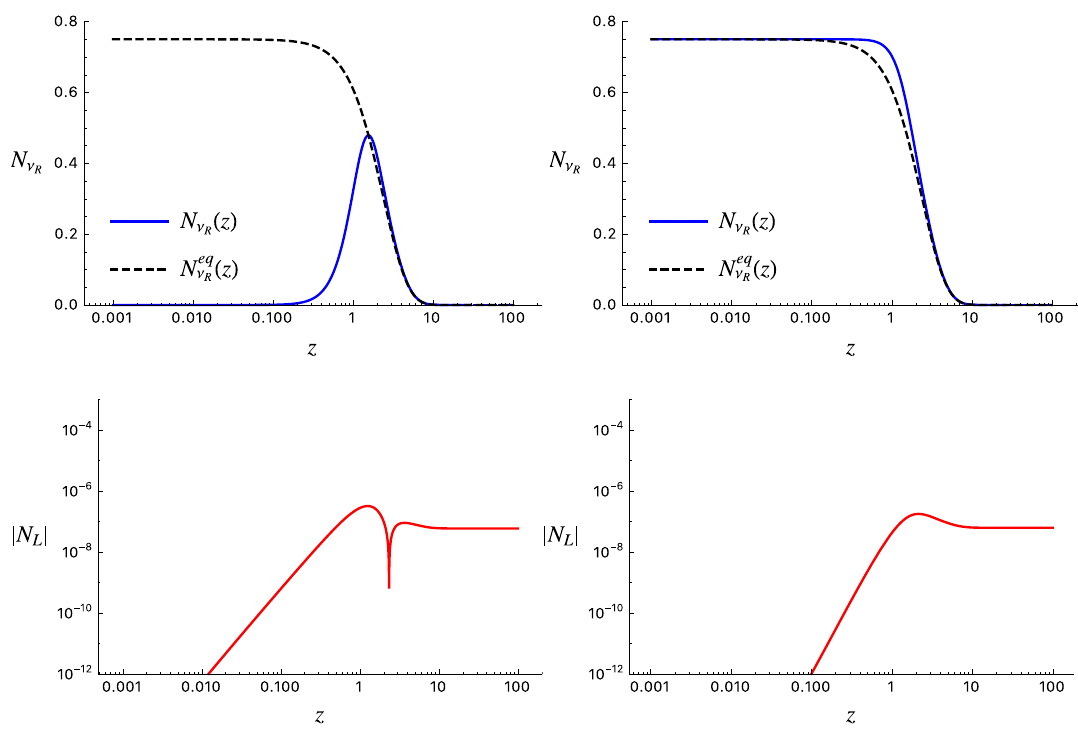
Figure 14 . The upper (cid:12)gures show the development of the sterile neutrino densities N (cid:23) left-hand diagram corresponds to an initial condition with N (cid:23) starts with N (cid:23) ( z ) already at its equilibrium value. The lower (cid:12)gures show the corresponding R absolute value of the lepton asymmetry induced by the out-of-equilibrium decays of (cid:23) 1 cusp in the left-hand plot, indicating that the asymmetry N L ( z ) changes sign as the sterile neutrino density N (cid:23) ( z ) switches from under to just over its equilibrium value. The parameters here are R M 1 = 5 (cid:2) 10 10 GeV and K = 5, with " 1 = 10 (cid:0) 6 . N ( z ) negative, as shown in the corresponding lower plot for j N L